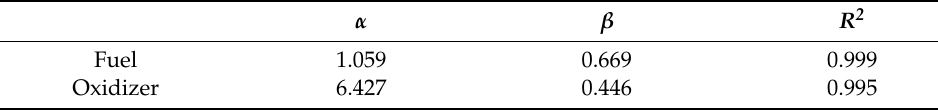
Figure 10. Mass flow rate calibration results of injector (left: fuel, right: oxidizer). Table 5. Calculation results of approximate coefficient.